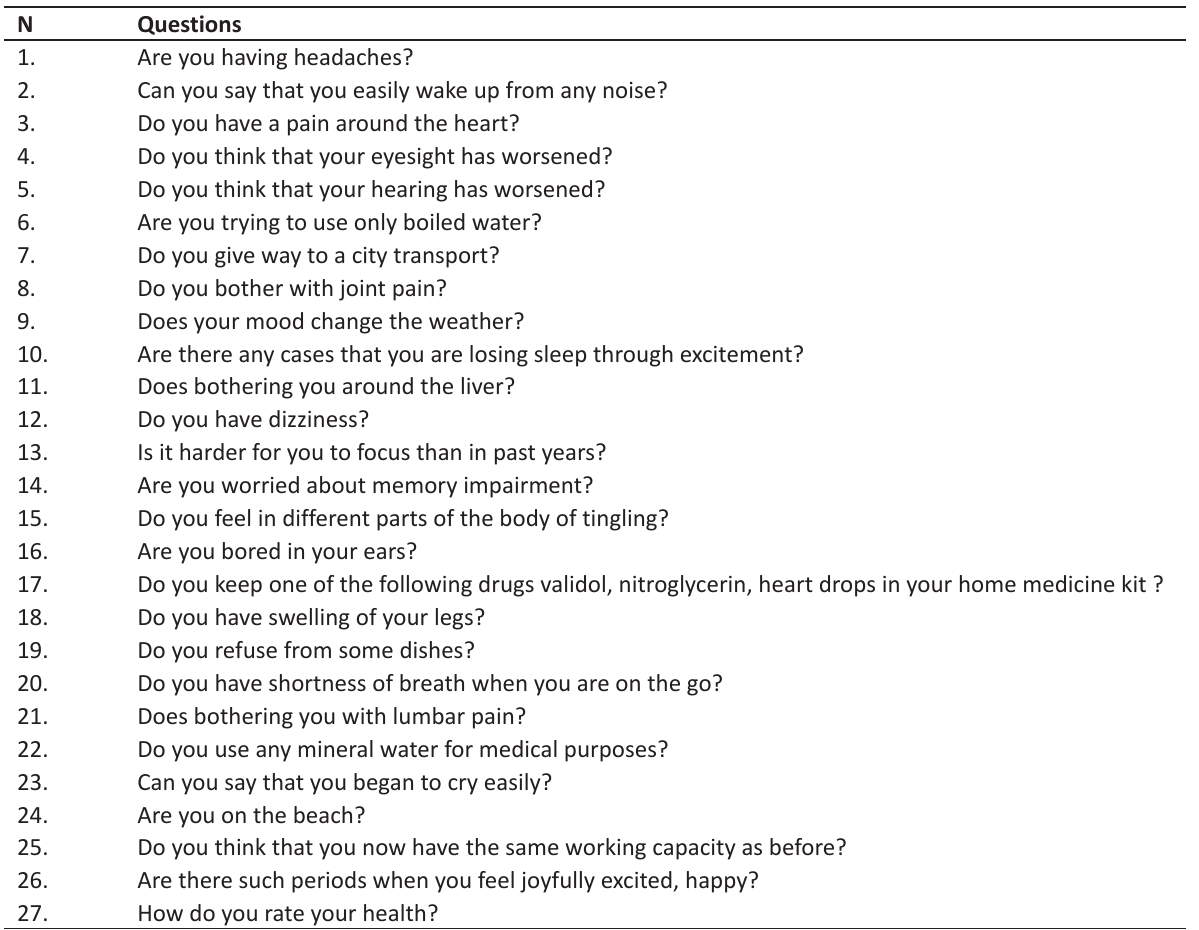
Table 1. Questionnaire for self-assessment of health [13]